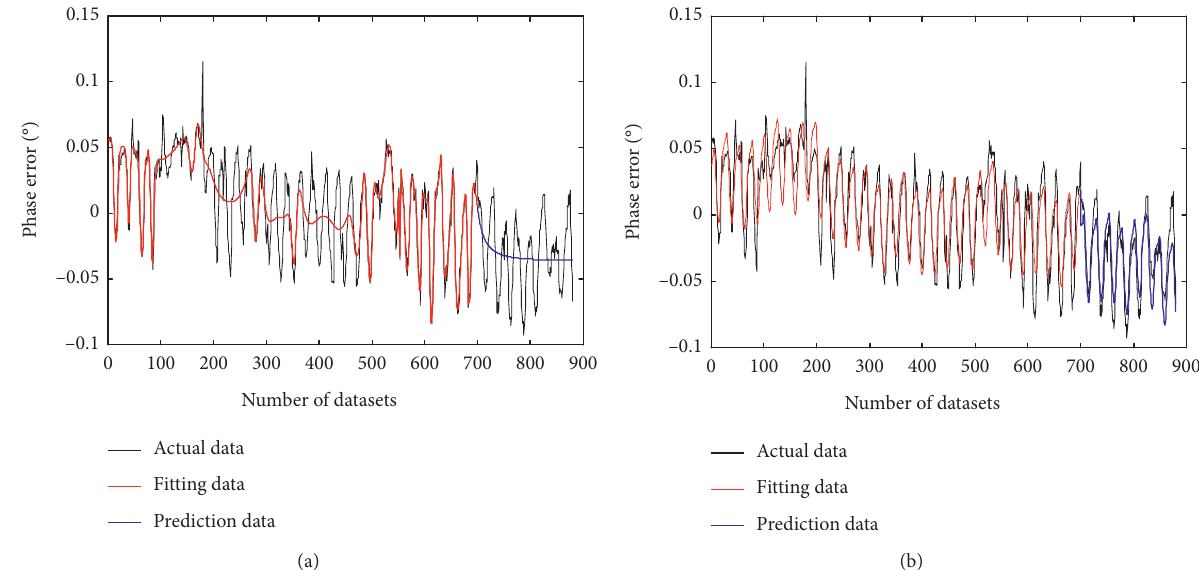
Figure 9: ET phase error prediction results. (a) Result of BPNN. (b) Result of the Prophet